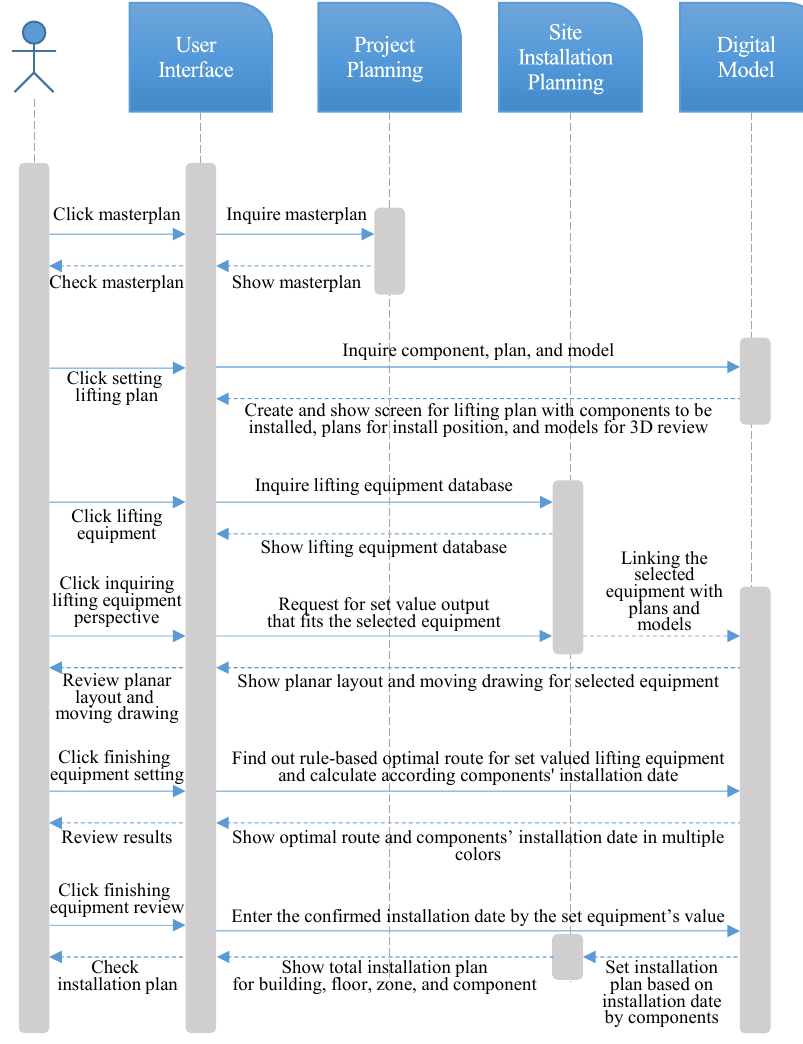
Figure 4. Sequence diagram for installation planning process.